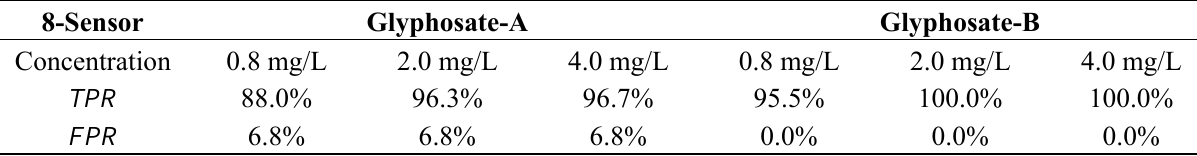
Table 3. The TPR and FPR performances of glyphosate-A and glyphosate-B